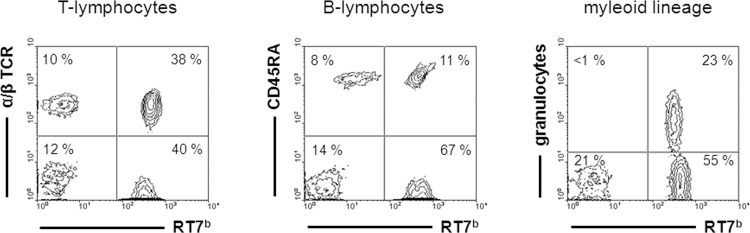
Multi-lineage chimerism in stable recipients of MHC haploidentical BM grafts conditioned by 15 mg/kg of anti-RT7a mAb at day 200.Blood samples of long-term surviving recipients of MHC haploidentical BMT (F1 (LEW.7B x LEW.1U-7B: RT1l/u RT7b) → LEW.1W: RT1u, RT7a) were analysed by flow cytometry for donor-derived chimerism (RT7b) within leukocyte lineages at day 200. Used mAbs were anti-α/β TCR mAb (R73) for T-lymphocytes, anti-CD45RA (OX33) for B-lymphocytes, anti-granulocytes (HIS48) for granulocytes and anti-RT7b (HIS41) for donor-derived cells.